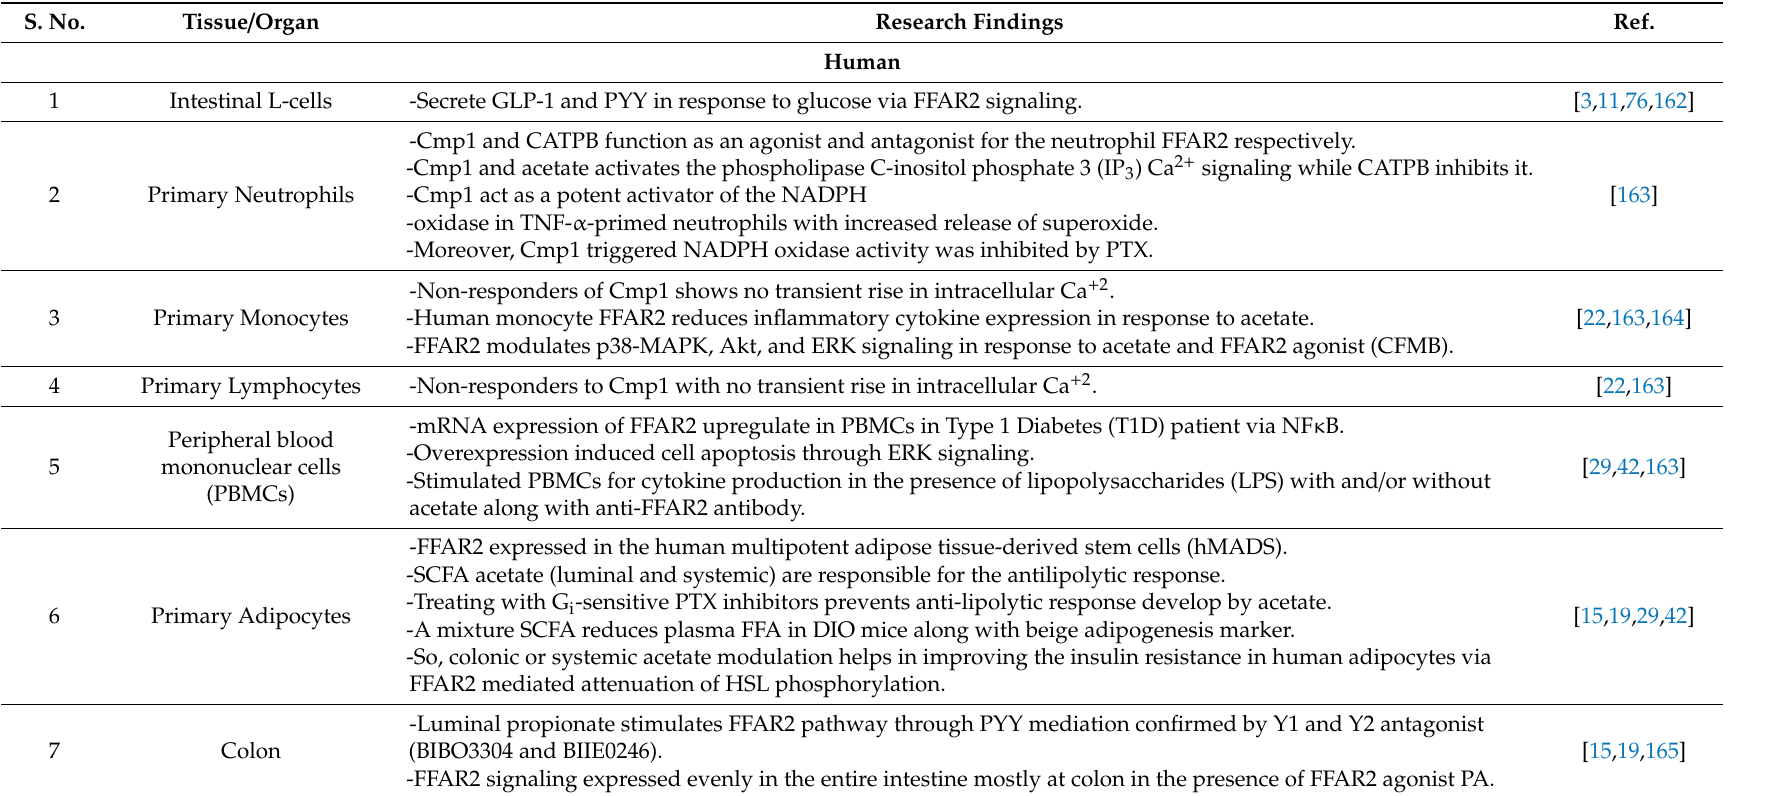
Table 2. Physiological function of FFAR2 in humans and